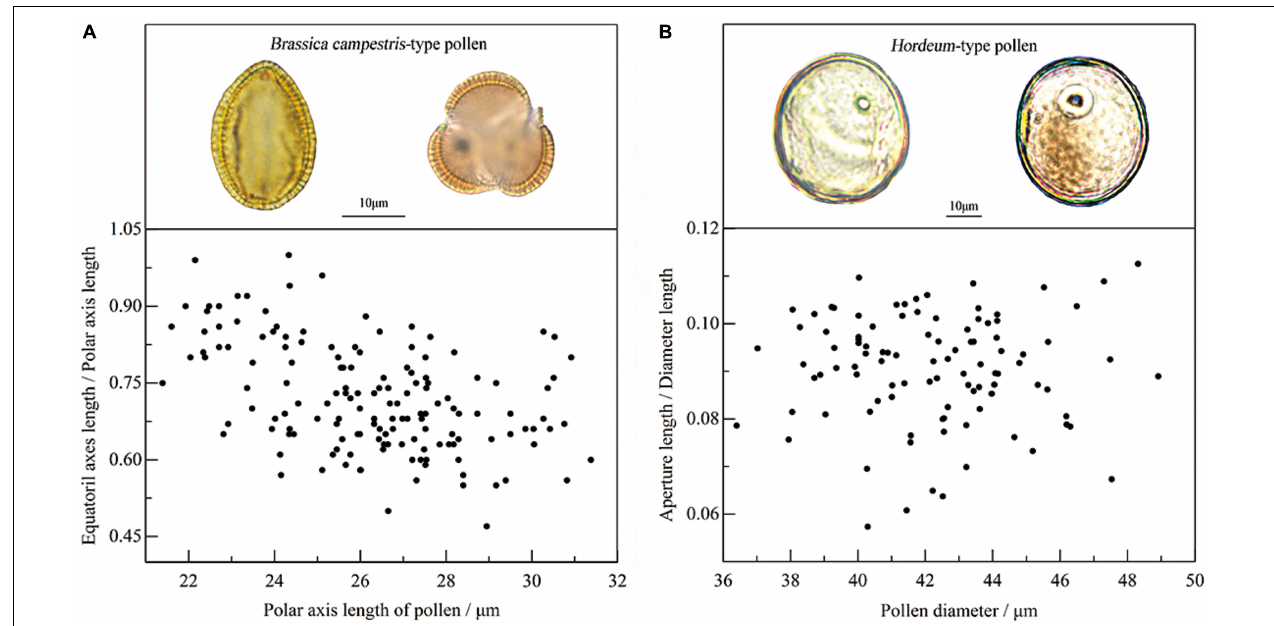
FIGURE 4 | Light microscopic images and morphological characteristics of Brassica campestris -type and Hordeum -type pollen. (A) Brassica campestris -type pollen; (B) Hordeum -type